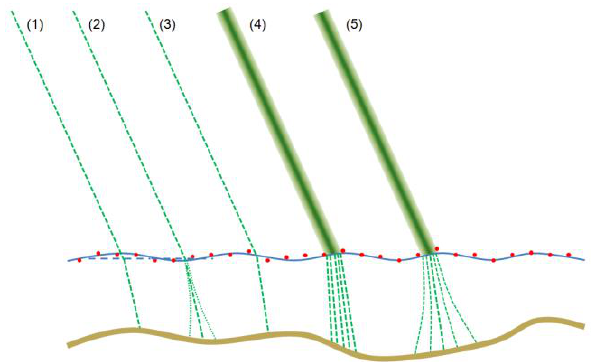
Figure 2: Different representations of the laser beam – water surface interaction (Westfeld et al., 2017)